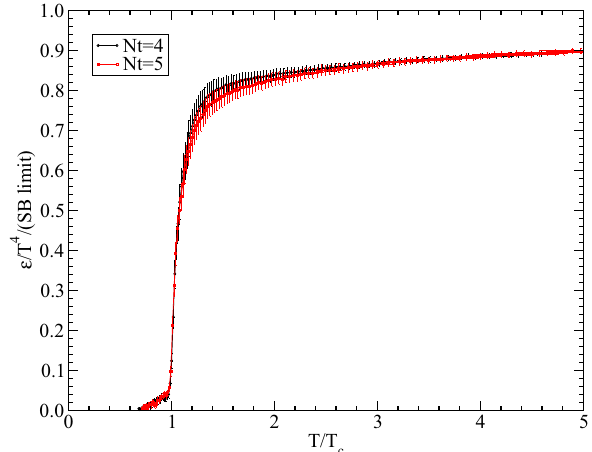
Fig. 15 Energy density (cid:12) normalised to the SB